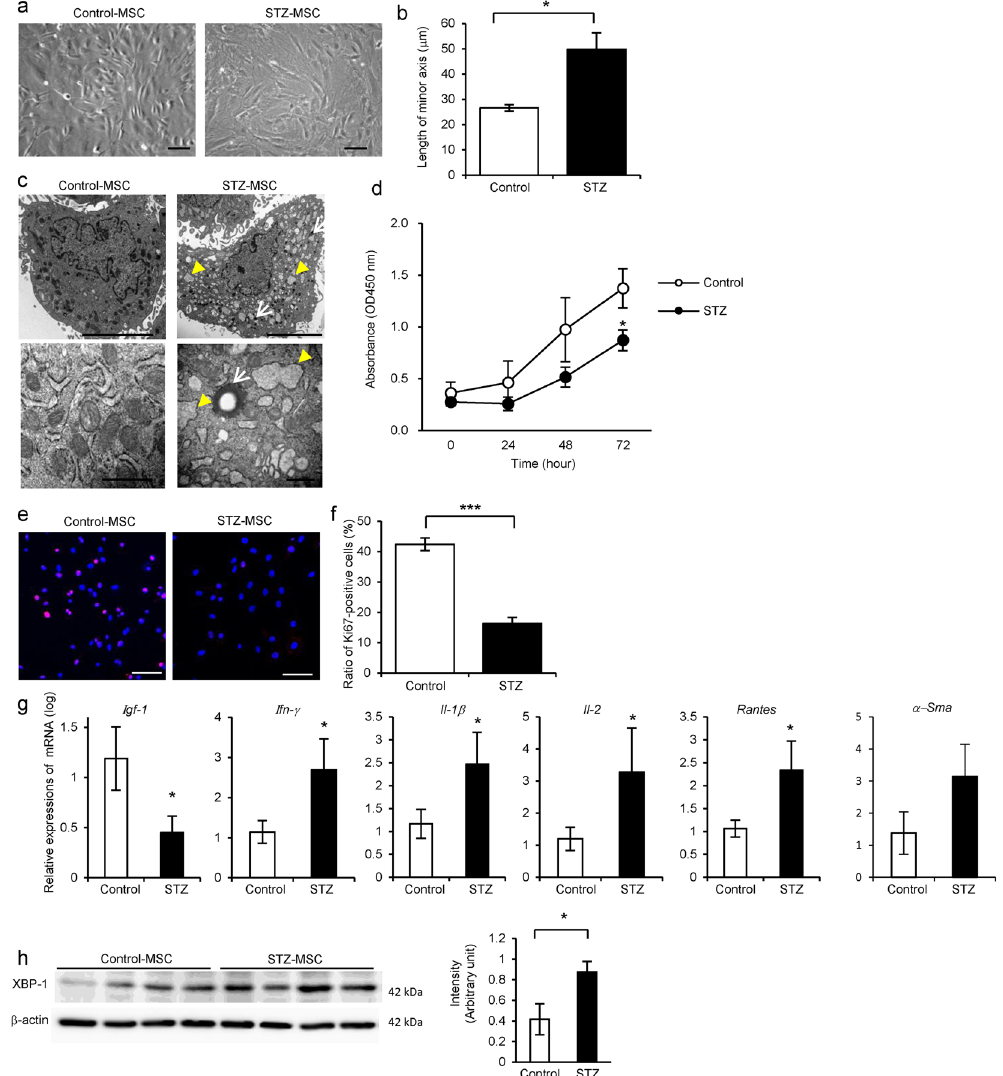
Figure 1. Abnormalities of bone marrow-derived mesenchymal stem cells (BM-MSC) isolated from streptozotocin (STZ)-induced diabetic rats (STZ-MSC) compared with control rats (Control-MSC). ( a ) Phase contrast images of Control-MSC and STZ-MSC (passage 3). Bar: 100 µ m. ( b ) Quantitative analysis of morphological findings of BM-MSC. The lengths of the minor axis in phase contrast images were measured in all cells in five panels of each BM-MSC isolated from individual animals. Values are means ± SE of Control- MSC (n = 3) and STZ-MSC (n = 4). * P < 0.05. ( c ) Transmission electron microscopy (TEM) images of BM- MSC. Upper panels show the entire cell at low magnification, whereas lower panels show cell organelles at high magnification. White arrows show mitochondria degenerations. Yellow arrow heads show abnormal dilation of the endoplasmic reticulum (ER). Bar: 5 µ m in upper panels and 500 nm in lower panels. ( d ) MTT proliferation assays of Control-MSC and STZ-MSC. Absorbance at 450 nm was measured 0, 24, 48 and 72 hours after the addition of MTT. Values are means ± SE of the control (n = 5) and STZ (n = 5). * P < 0.05. ( e ) Immunofluorescence staining of BM-MSC with anti-Ki-67 antibody (red). DAPI was used for counterstaining nuclei (blue). Bar: 100 µ m. ( f ) The average ratio of Ki-67-positive cells to the total cell count. The number of Ki-67-positive cells and nuclei were counted in five panels of each BM-MSC isolated from individual animals. Values are means ± SE of the control (n = 4) and STZ (n = 5). *** P < 0.001. ( g ) Relative expressions of mRNA in BM-MSC. Values are means ± SE of the control (n = 4) and STZ (n = 3). * P < 0.05. ( h ) Western blot analysis of Control-MSC (n = 4) and STZ-MSC (n = 4) using anti-XBP-1 and β -actin antibodies. Relative amounts of protein are normalized to an internal control, β -actin. The cropped images of immunoblots displayed in the figure and the full-length blots were shown in Supplementary Fig. S11. Data are expressed as mean ± SE values * P <